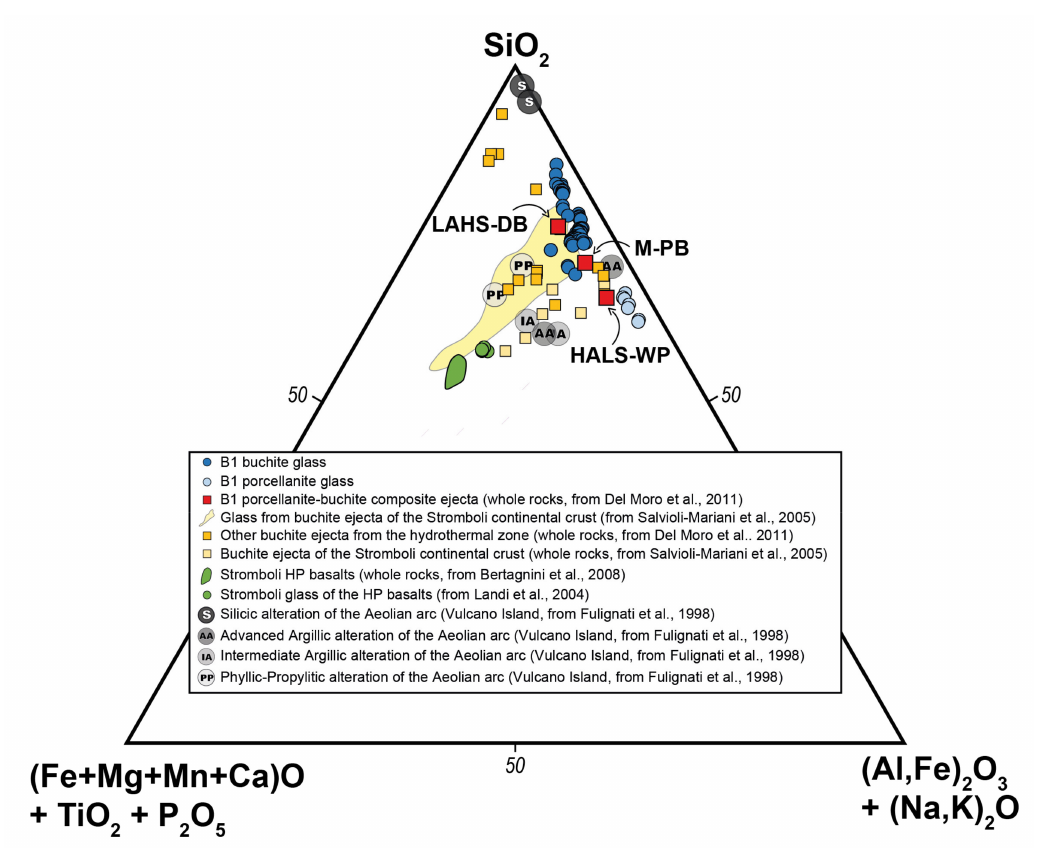
Figure 9. Ternary diagram (from Grapes [1]) of the major element oxides in mol.% for bulk rock compositions and glass of the investigated porcellanite–buchite xenolith (B1) and the buchite suites from Del Moro et al. [21] and Salvioli-Mariani et al. [17]. The B1 porcellanite–buchite composite sample is highlighted with its three analyses (end members HALS–WP, LAHS–DB and the intermediate composition M–PB). Data from Stromboli HP basalt whole rocks [37] and glass [85] are also reported for